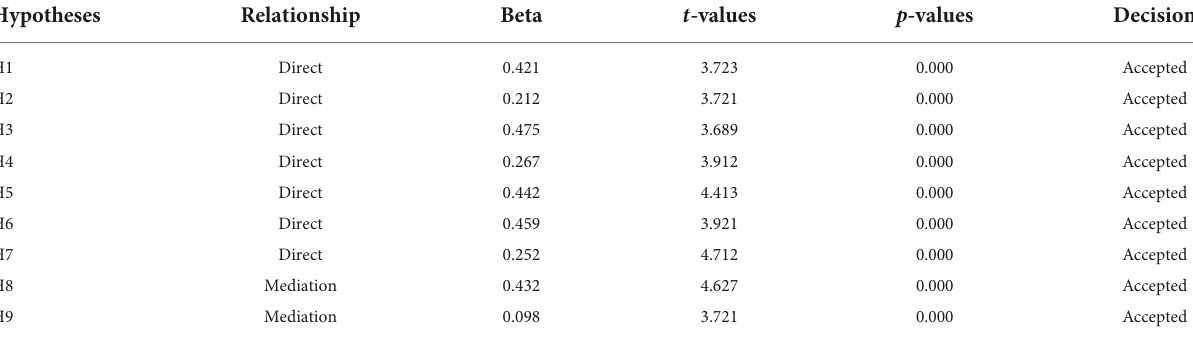
TABLE 5 Standardized path